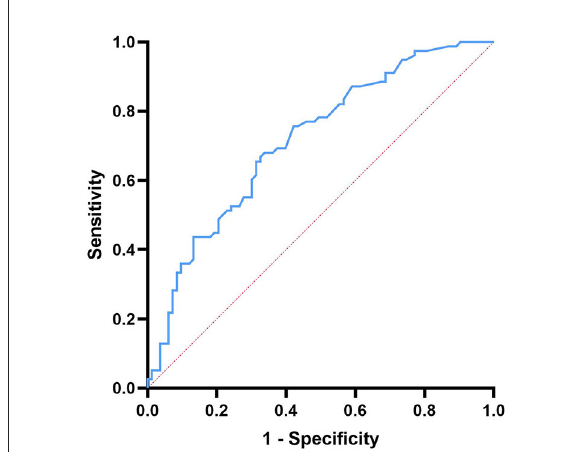
FIGURE2 Receiver operating characteristic curve showing the predictive ability of D-dimer for disease severity.